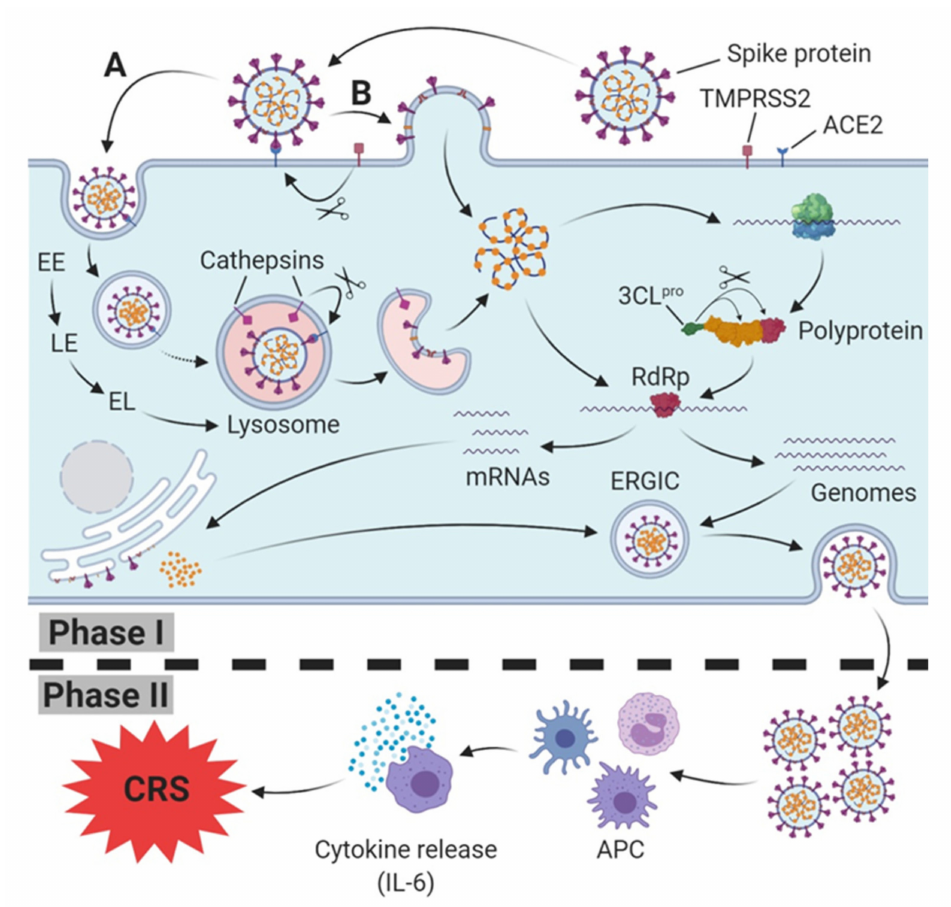
Figure 1. SARS-CoV(-2) host cell infection, replication ( Phase I) and induction of immune response ( Phase II ). Spike protein (S protein) of SARS-CoV-2 binds to host cell membrane presented ACE2 (cellular receptor); it either enters the endocytic pathway ( A ) or fuses via TMPRSS2-mediated cleavage of the ACE2-S protein complex directly with the cell membrane ( B ). Traveling down the endosomal pathway, the maturation of early endosomes (EE), via late endosomes (LE) to early lysosomes (EL), and finally lysosomes, is accompanied by vacuolar acidification (indicated as red area). In late endosomes / lysosomes, the ACE2-S protein complex is cleaved via cathepsin L, resulting in the fusion of the viral and host cell membrane. After release into the cytoplasm, translation of viral RNA into the polyprotein takes place. Afterwards, the polyprotein is cleaved into several active non-structural proteins by the chymotrypsin-like protease subunit (3CLpro), including RNA depending RNA polymerase (RdRp). RdRp subsequently synthesizes progeny genomes and subgenomic mRNAs translated to structural proteins at the endoplasmatic reticulum. Both structural proteins and progeny genomes meet in the endoplasmic reticulum-Golgi intermediate compartment (ERGIC), resulting in the assembled SARS-CoV-2 virus. Finally, the nucleocapsid is released from host cell via exocytosis. In Phase II, SARS-CoV-2 is recognized and internalized by antigen presenting cells (APC), triggering an innate immune response which is accompanied by a release of cytokines, including Interleukin-6 (IL-6). In severe cases, a massive release of IL-6 leads to the cytokine release syndrome (CRS). The endosomal entry route of SARS particles bound to ACE2 and the subsequent maturation of early endosomes (EE) via late endosomes (LE) to endolysosomes (ELs), and finally lysosomes, has been substantiated by evidence that E64d (cysteine protease inhibitor) and bafilomycin A1 + (inhibitor of vacuolar H ATPase (V-ATPase) (BRENDA:EC 3.6.3.6) and vacuolar acidification) block SARS-CoV(-2) S-protein-mediated endosomal entry [4,53,55]. The lysosomotropic cathepsin L inhibitor teicoplanin [45], a glycopeptide antibiotic, and Bafilomycin A1, via preventing